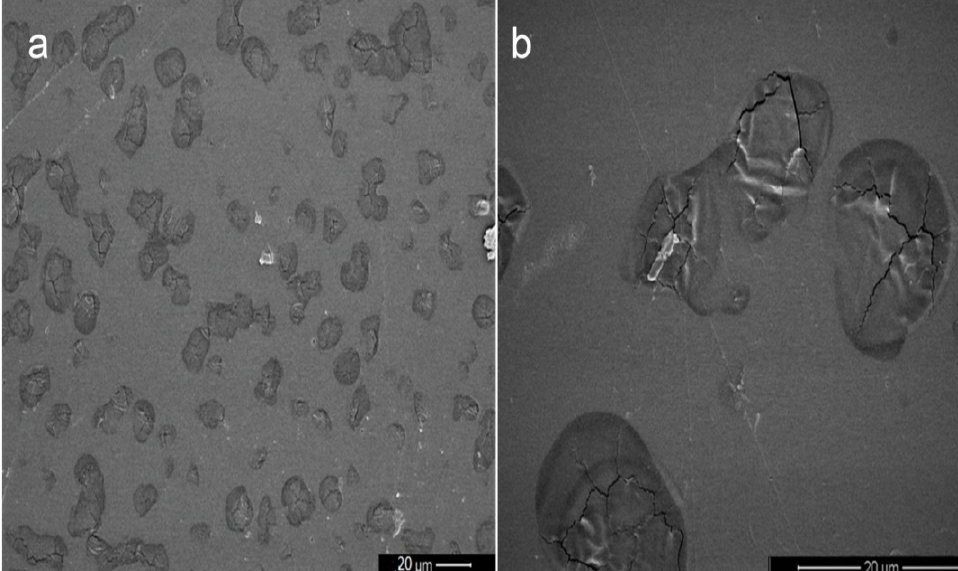
Figure 2. SEM images of the dried discs of KT-CTS gel. ( a ) Magnification 1000×; and ( b ) magnifica- tion 5000×; the scale bar is 20 µm length.